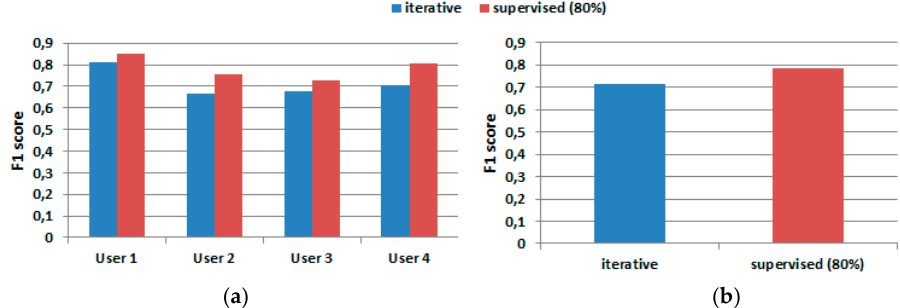
Figure 10. F 1 score comparison for IMU and 3-axial acceleration sensors fused data. ( a ) Results for each user; and ( b ) average F 1